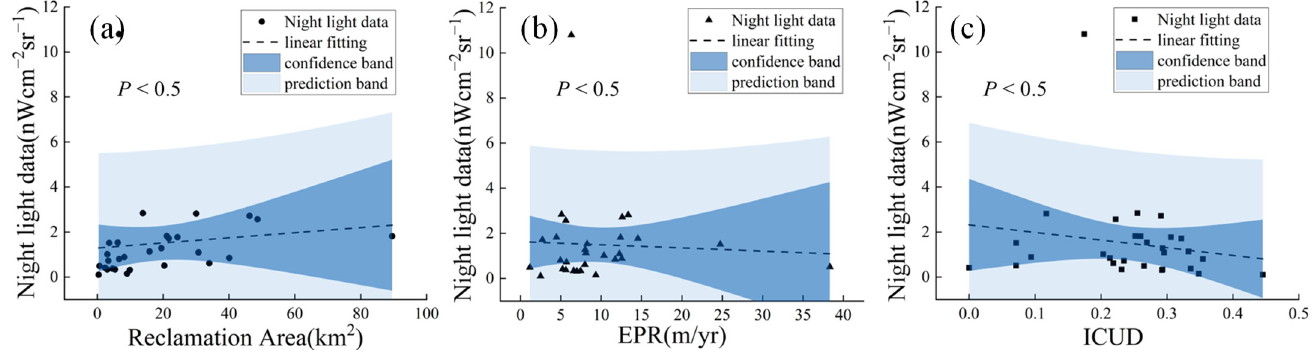
Figure 8. The relationship between night light data and ( a ) reclamation area, ( b ) EPR , ( c ) ICUD at the county level.